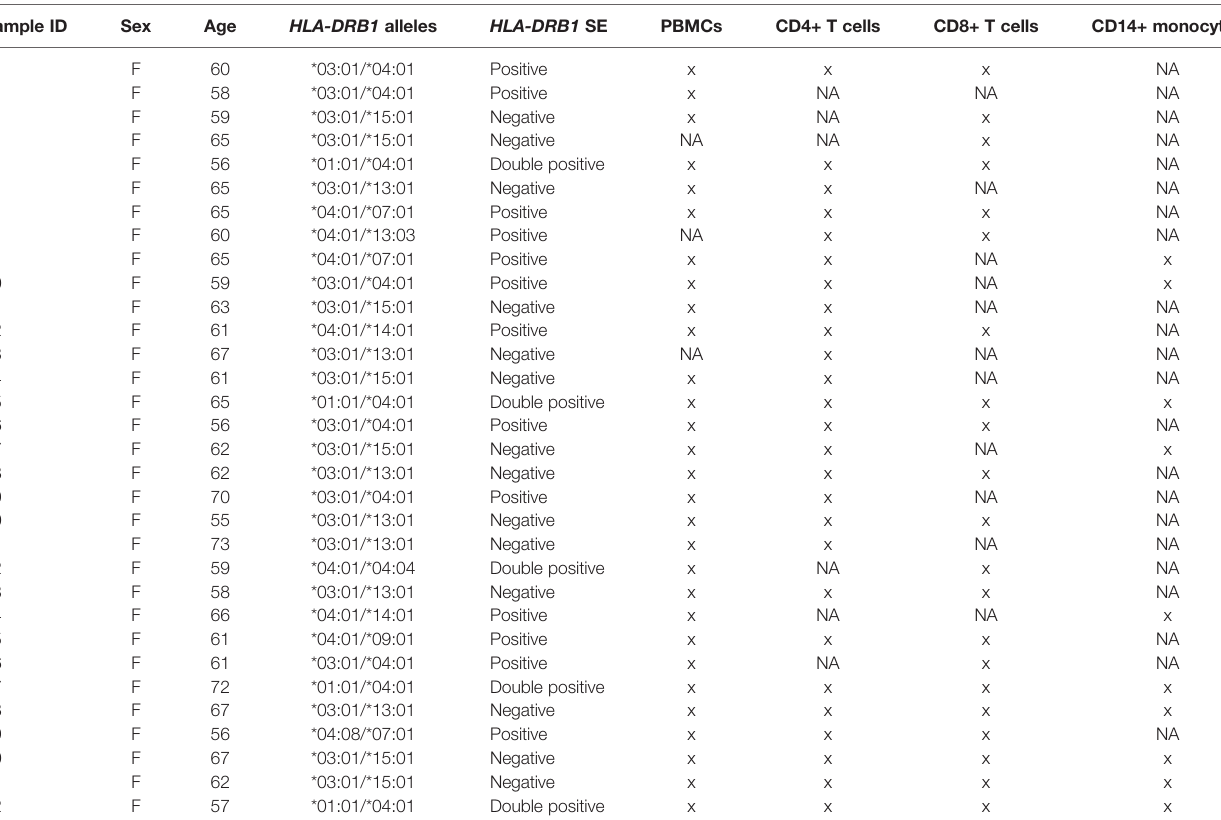
TABLE 1 | Characteristics of study